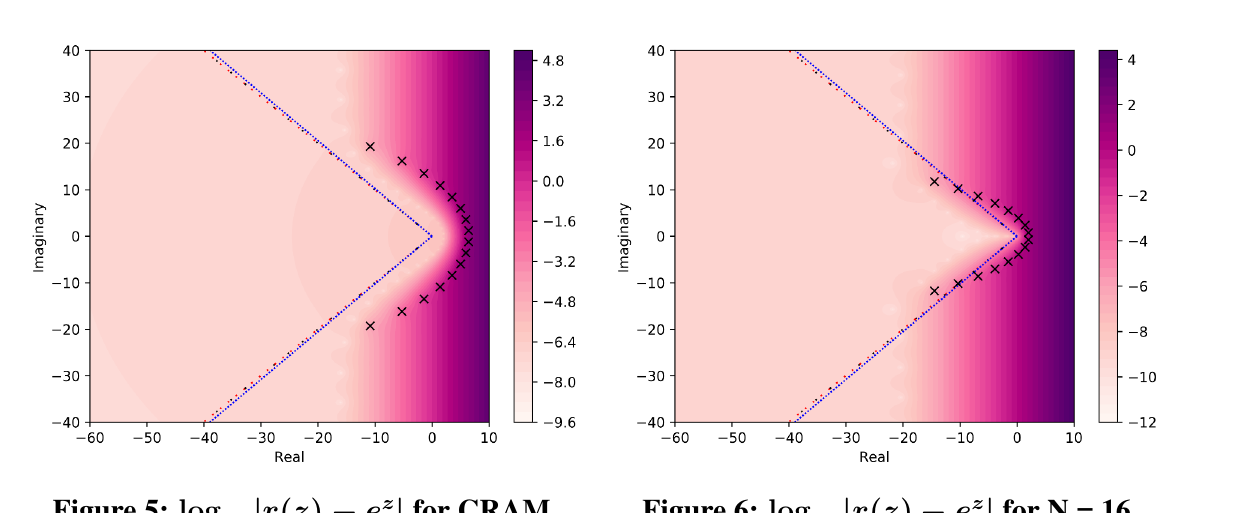
| r ( z ) − e z | for CRAM Figure 5: log 10 of order 16